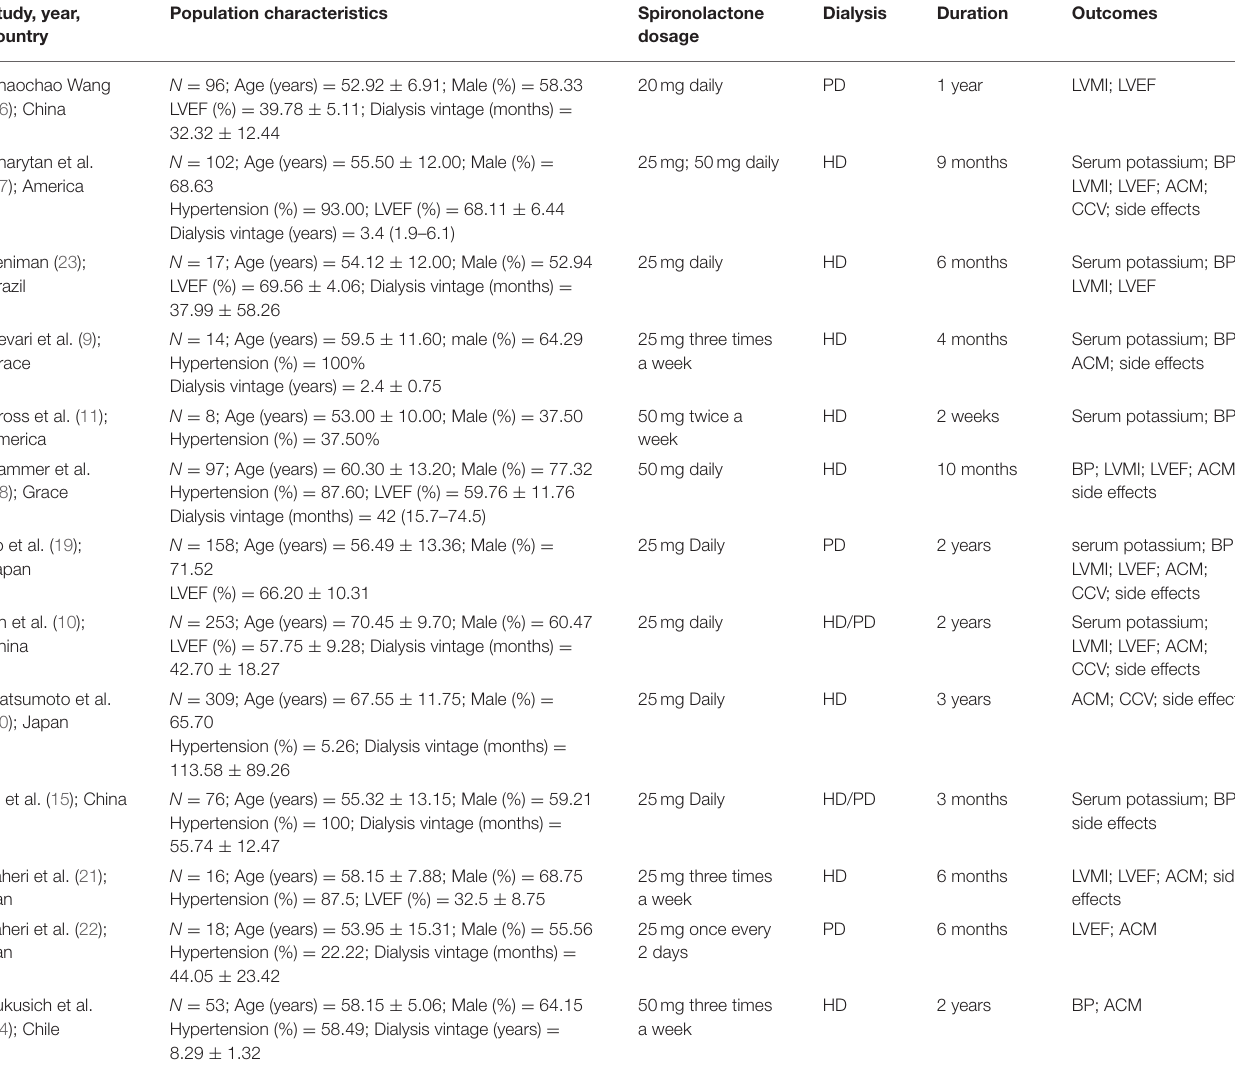
TABLE 1 | Characteristics of enrolled